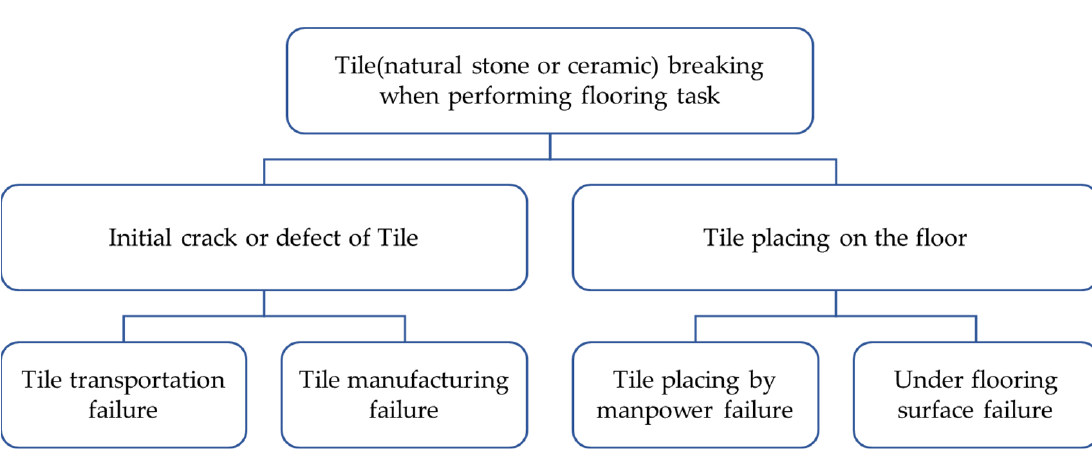
Figure 9. Fault tree for ‘Tile (natural stone or ceramic) breaking when performing flooring task’. Table 7. FMEA severity, occurrence, and detection indexes [46].